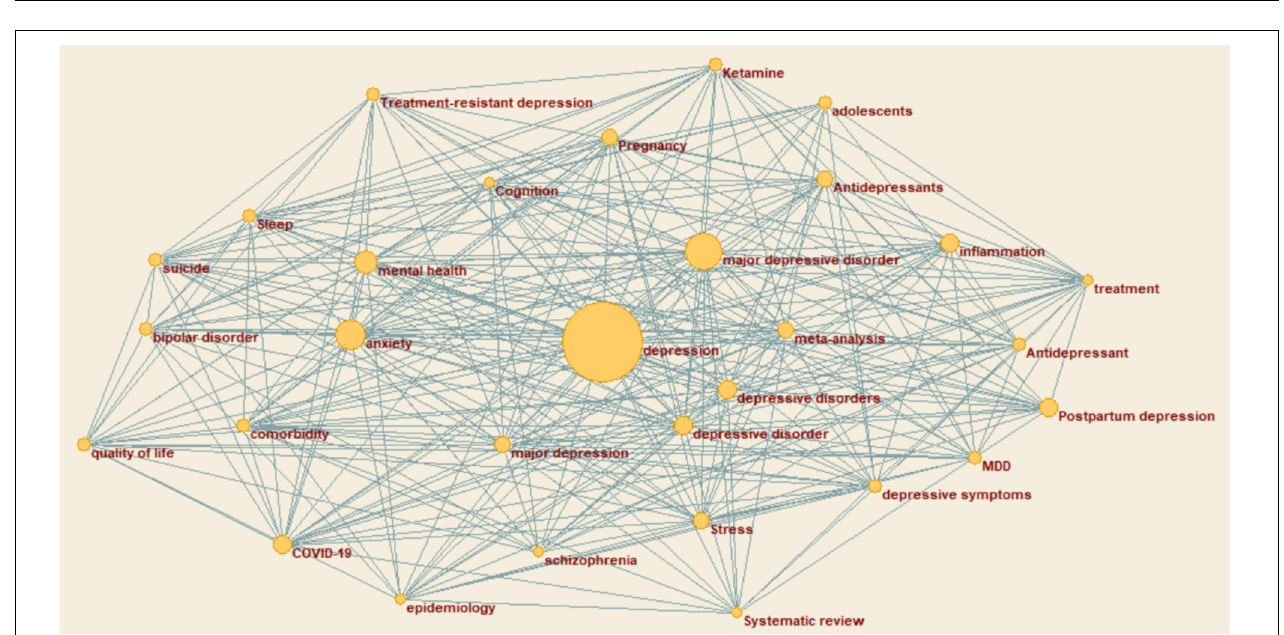
FIGURE 2 | Development of paper numbers and keywords as marker fields.